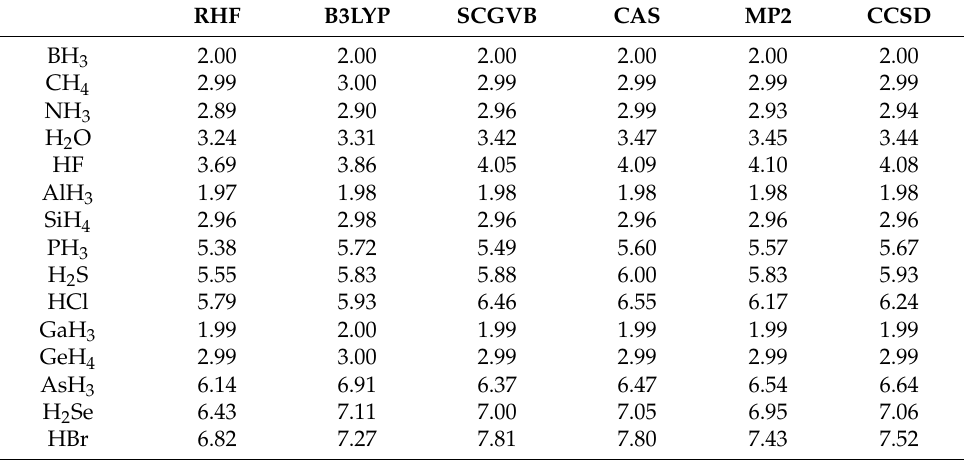
Table 1. Hybrid p -character ( λ ) of X–H bonding hybrids for the first-, second-, and third-row hydrides a . RHF